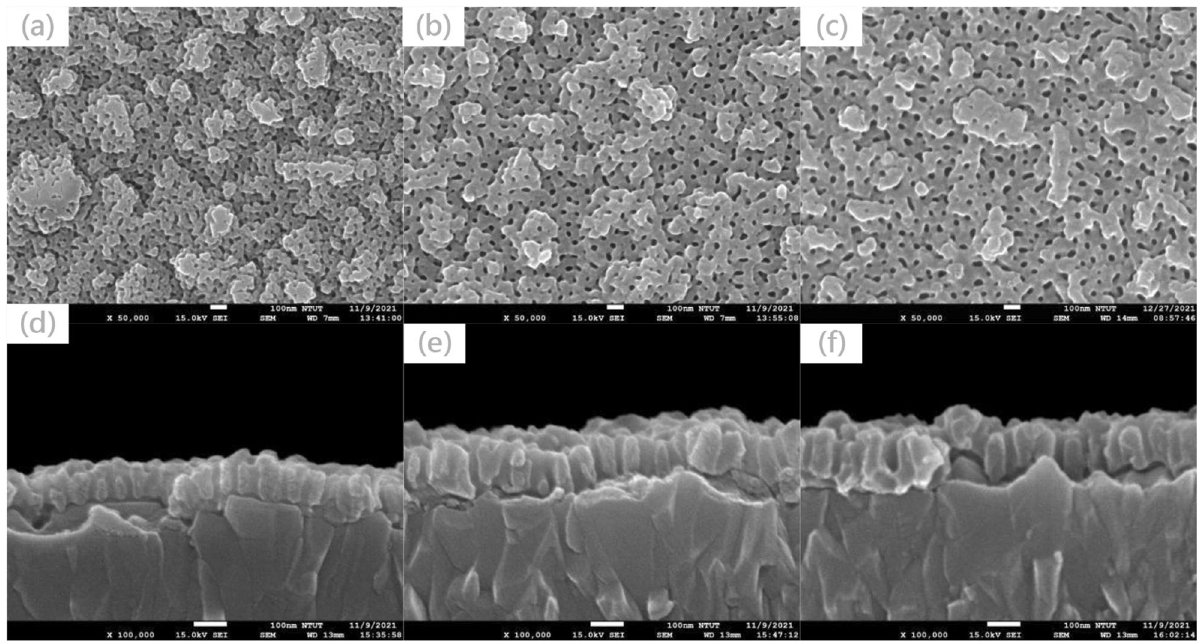
Figure 2. Top view and cross-sectional SEM images of AAO with various pore-expanding voltages: ( a , d ): 30 V, ( b , e ): 40 V; and ( c , f ): 50 V.